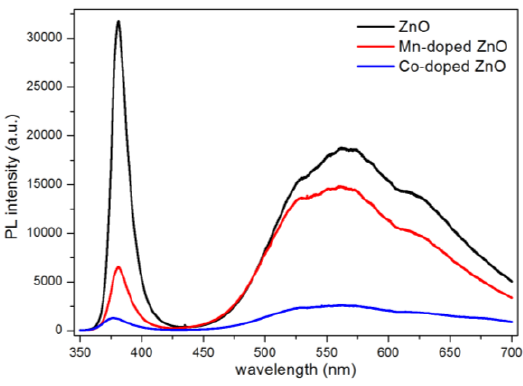
Figure 5. Photoluminescence (PL) spectrum of ZnO, Mn-doped ZnO and Co-doped ZnO.